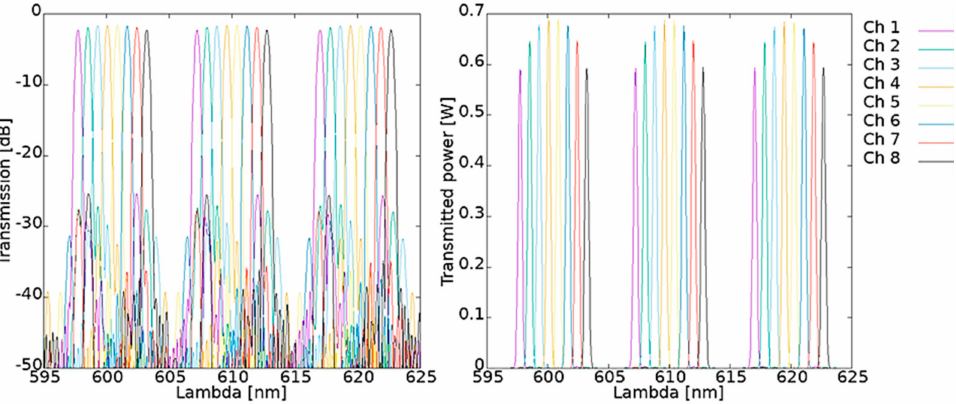
Figure 6. Simulated output spectra of AWG 100 GHz 1 × 8, λ c = 610 nm.